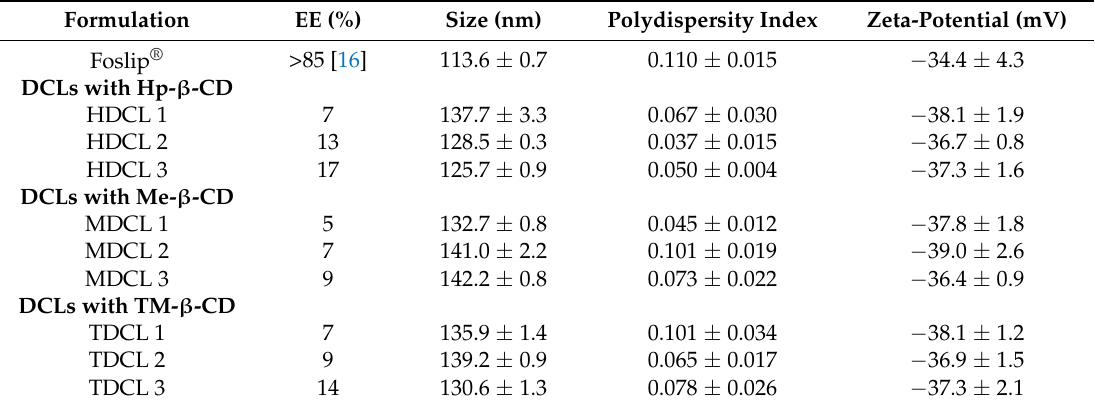
Table 2. Characterization parameters of different liposomal formulations of mTHPC.